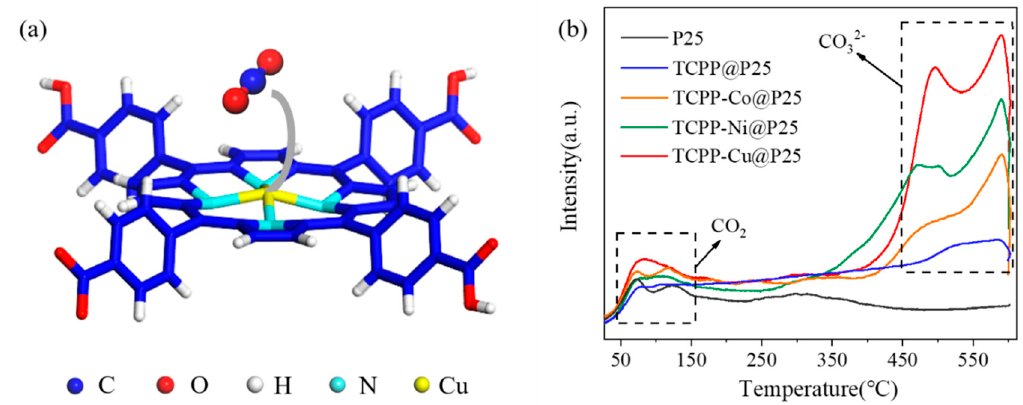
Figure 3. ( a ) The optimized structure for CO 2 adsorption on a TCPP-Cu unit; ( b ) CO 2 -TPD spectra of